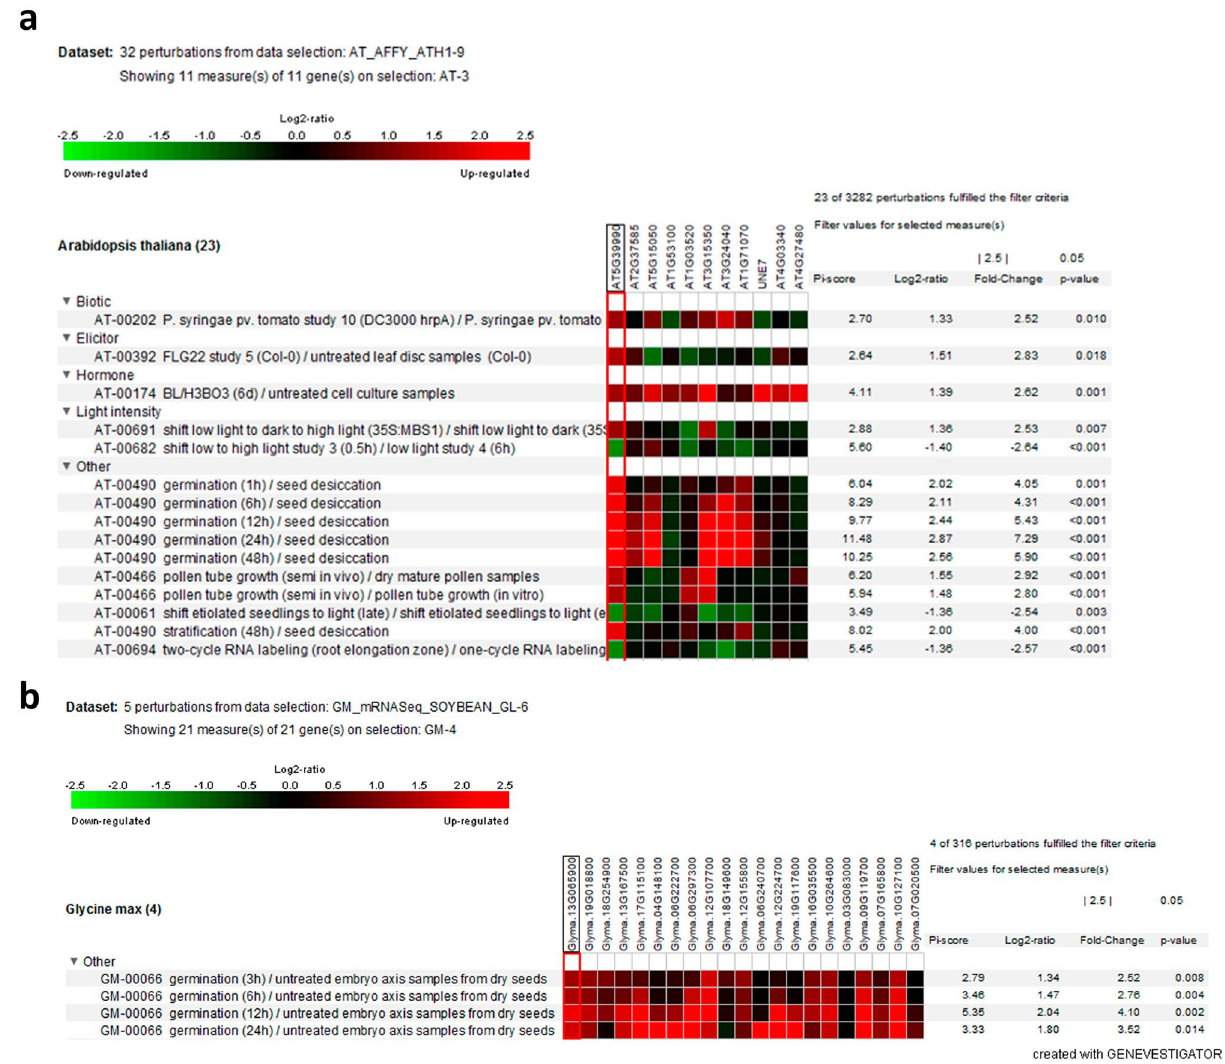
Figure 6. Digital expression pattern of putative GLCATs in Arabidopsis and soybean during germination. ( a ) Expression pattern of GLCAT genes in Arabidopsis thaliana during germination. ( b ) Expression pattern of GLCAT genes in soybean during germination. The red boxed regions indicated the A tGLCAT14A (AT5g39990) gene and its ortholog in exons. Also, syntenic regions were identified between A thaliana and its orthologs in the investigated genomes using Circoletto 38 . The color represented the extent of similarity, blue for the lowest similarity, followed by green, orange and red, showing the increasing extent of similarity with increasing bit score. Specifically, blue for the first (i.e. worst) 25% of the maximum bitscore, green for the next 25%, orange for the third, and red for the top (i.e., best) bitscores of between 75 and 100% of the maximum bitscore 38 . Motif identification in GLCAT sequences in plant genomes. For motif identification, conserved motifs among GLCATs were identified using the MEME program 39 with the following parameters: number of repetitions = zero or one, maximum number of motifs = 6, and optimum motif width constrained between 6 and 50 residues.